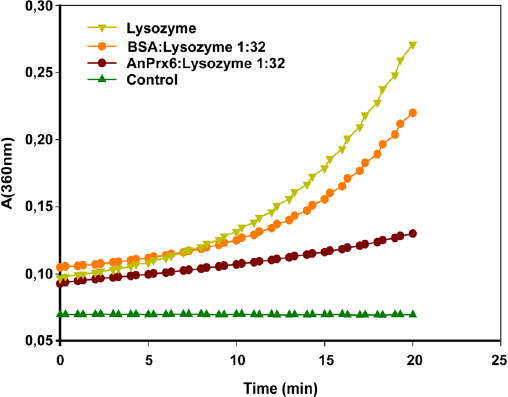
Figure 4. Chaperone activity assay. Thermal aggregation of HEWL at 43 °C was monitored at a wavelength of 360 nm by measuring the degree of light scattering at different time points. The reference level of scattering was determined with a reaction mixture containing only buffer, HEWL and DTT (light green triangles). Aggregation is strongly reduced in the presence of dilute AnPrx6 (brown dots), whereas the same dilution of BSA (positive control) has almost no effect on aggregation (orange dots). Buffer and DTT (dark green triangles) were used as negative control